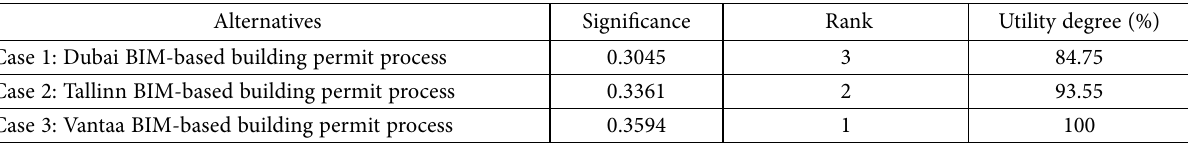
Table 9. Results of the readiness assessment based on